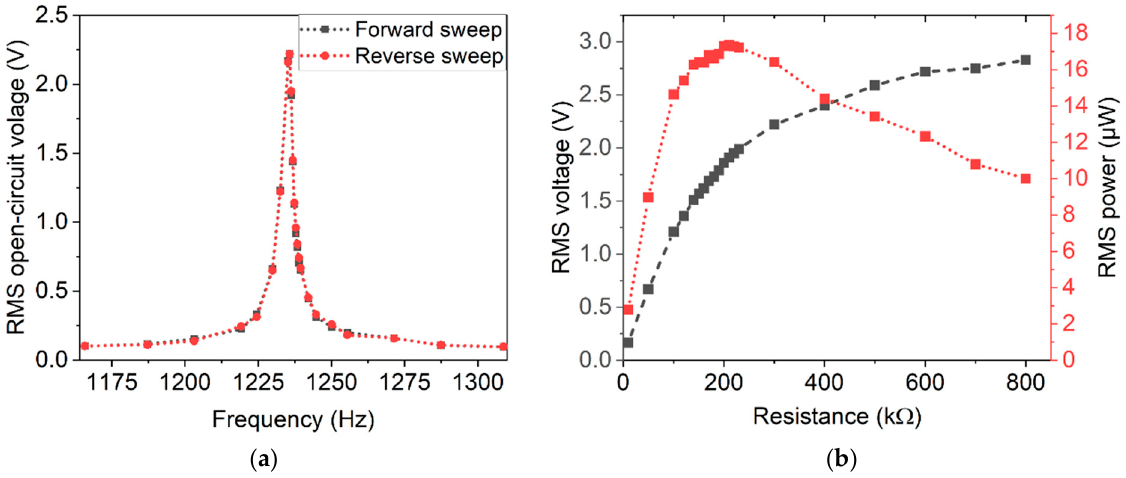
Figure 11. Representative measurements of open-circuit voltage in dependence of the excitation frequency, close to the resonance frequency of a design 2 harvester. ( a ) The resonance curve for a forward and a backward frequency sweep. ( b ) Typical measurements of the voltage and power output of a harvester with respect to applied ohmic loads. Table 4. Resonance frequencies, Q-factors, calculated damping ratios and internal resistances for the different designs in the case of magnetic excitation.